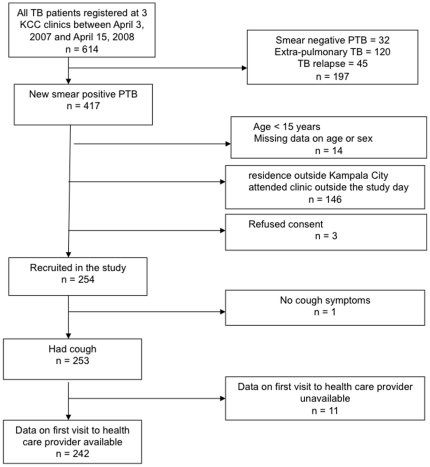
Flowchart showing the patients included in the analysis of diagnostic delay in Kampala, Uganda 2007-8.Legend: KCC = Kampala City Council, TB = Tuberculosis, PTB = Pulmonary tuberculosis.